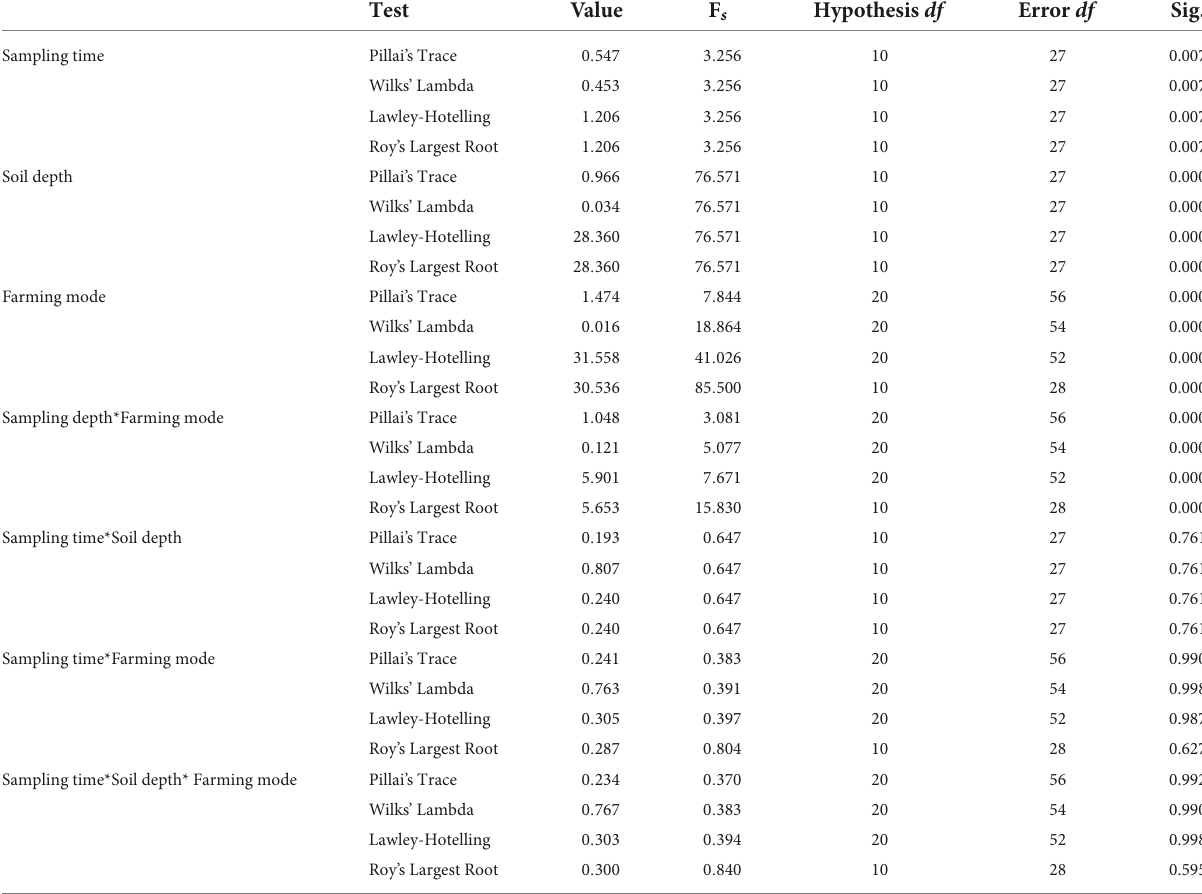
TABLE 2 MANOVA results for soil samples collected during different farming practices within different soil depths and sampling months. Test Value F